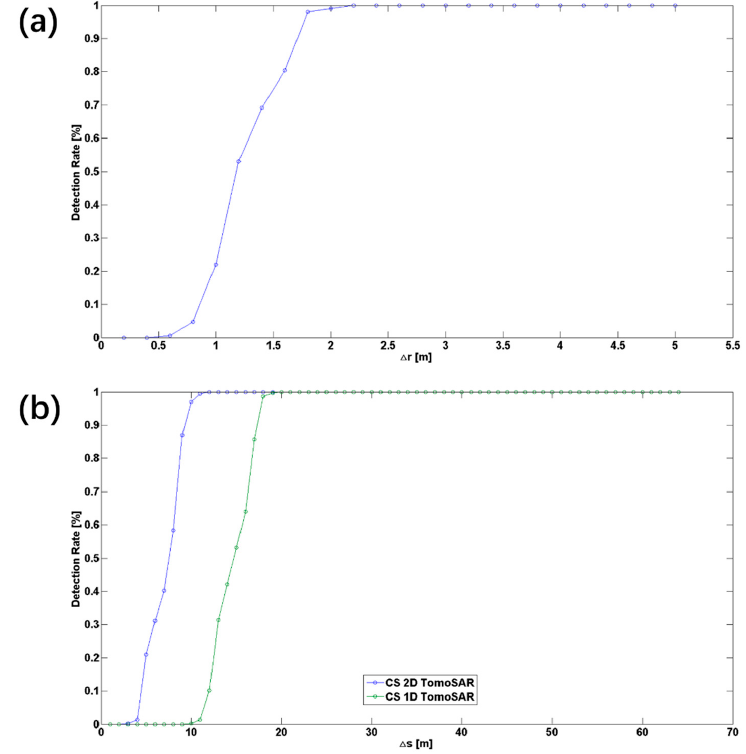
Figure 8. Detection rate as a function of ( a ) ∆ r at ∆ s = 0 m and ( b ) ∆ s at ∆ r = 0